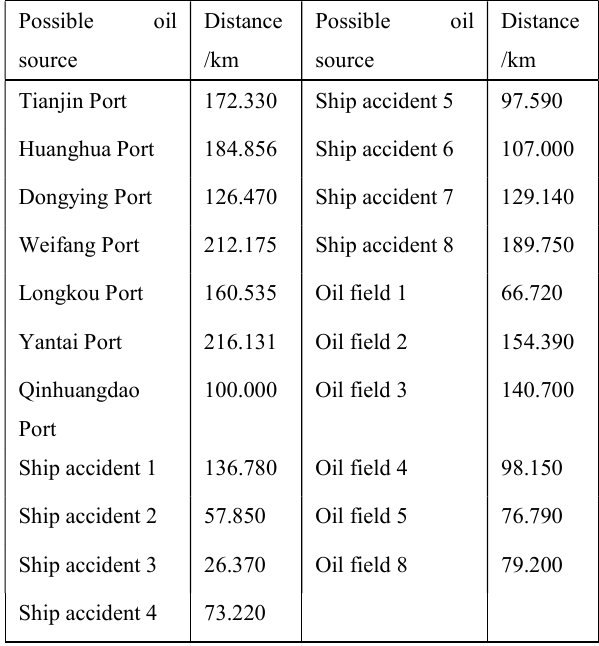
Table 2. Distances of oil spill point to oil source